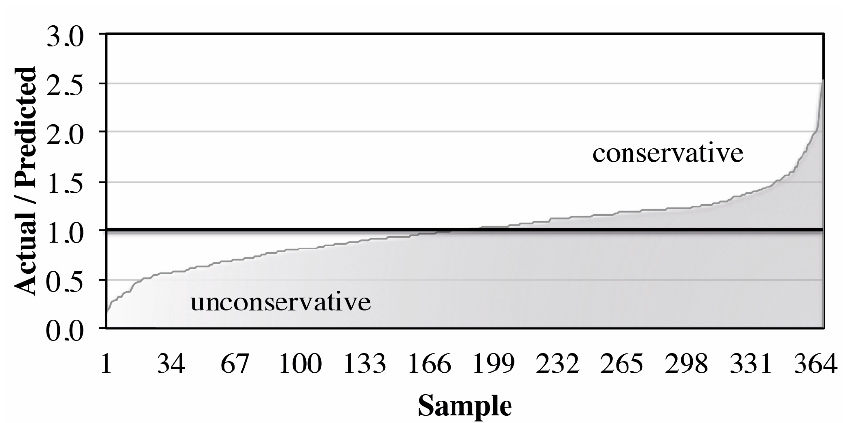
Figure 8. Area graph of the actual/predicted P u .